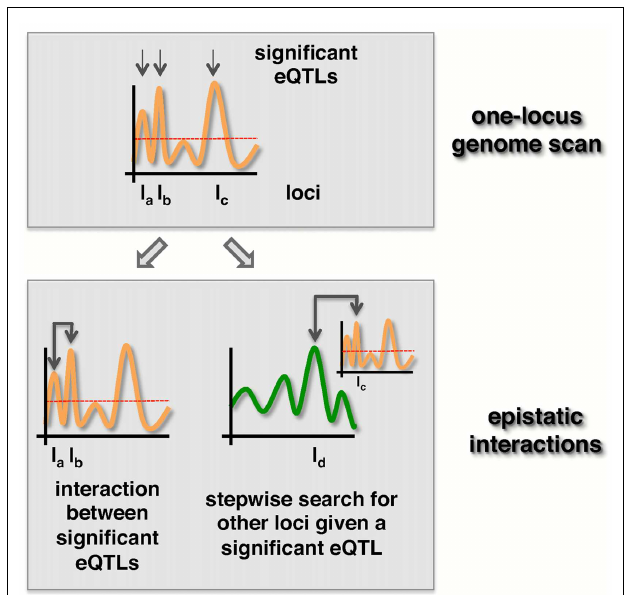
FIGURE 2 | “Both significant” and “Either significant” strategies to detect epistatic effects. First, loci with p -values that exceed a significance threshold (dotted line) are selected. In the “Both Significant” strategy (left) all pairs of significant eQTLs are tested for the presence of an epistatic interaction in a second step. In turn, loci uncovered in the first step are tested for epistasis with all other loci in the “Either Significant” strategy